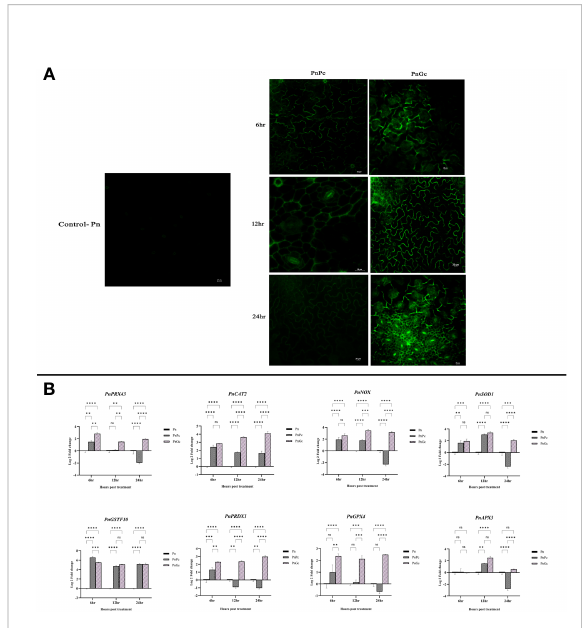
FIGURE 4 Visualization of ROS production using DCFDA staining in detached leaves of P. nigrum under 20X magni fi cation. The green fl uorescence in the fi gure is indicative of the ROS production after different treatments. Scale bar: 20 m m (A) Pn: Control P. nigrum , PnPc: P. nigrum infected with P. capsici at 6, 12 & 24hpi, PnGc: P. nigrum in fi ltrated with GC at 6, 12 & 24h (B) Expression analysis of hypersensitive response genes ( PnPRX43: Peroxidase , PnCAT2 : Catalase, PnNOX: NADPH Oxidase, PnSOD1: Superoxide dismutase, PnGSTF10 : Glutathione S- Transferase, PnPRDX1: Peroxiredoxin, PnGPX4 : Glutathione peroxidase, PnAPX3: Ascorbate peroxidase) under different treatments ( P. nigrum control (Pn), P. nigrum infected with P. capsici (PnPc ) , P. nigrum in fi ltrated with GC (PnGc) at 6,12 & 24h